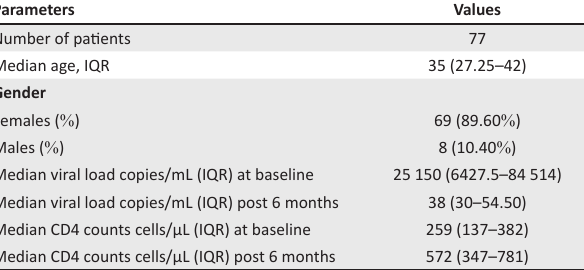
TABLE 1: Characteristics of the study